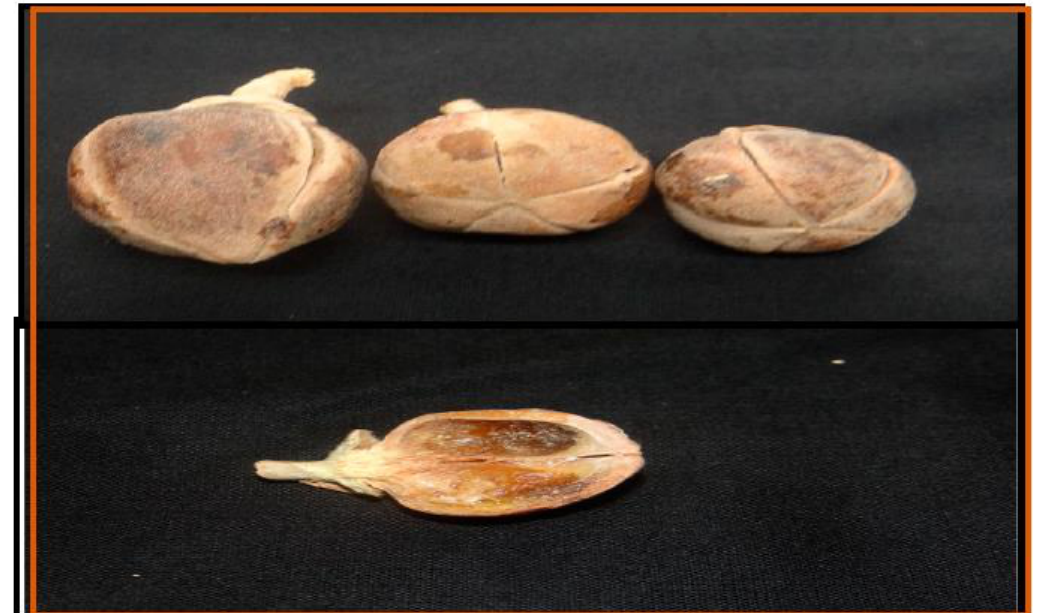
Figure 1. Azanza garckeana fruit .